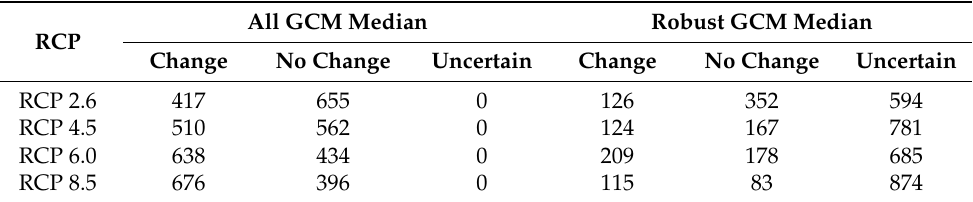
Table 9. Total numbers of FRIs (out of 1072) projected with a change in flood timing in Canada. All GCM RCP